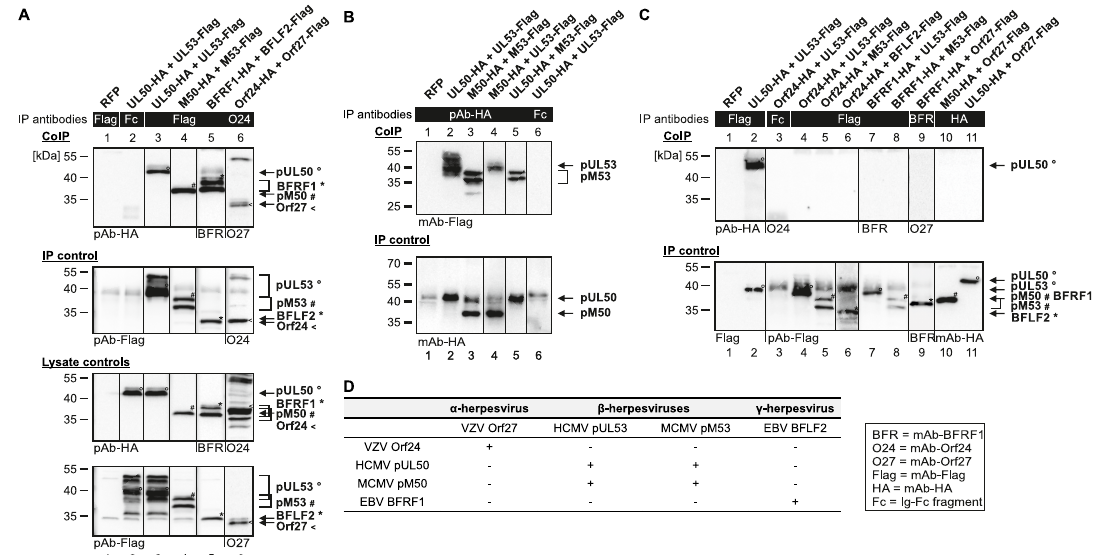
Figure 3. CoIP-based interaction analysis of nonautologous NEC protein pairs derived from HCMV, MCMV, EBV and VZV. 293T cells were transiently transfected with expression plasmids coding for HA-tagged and Flag-tagged versions of NEC proteins as indicated. At three d p.t., cells were lysed and HA- or Flag-tagged proteins were immunoprecipitated using mAb-Flag, mAb-Orf24 (A), pAb-HA (B), mAb-Flag, mAb-BFRF1, mAb-HA (C) or antibody Fc fragment (mouse (A, C) or rabbit (B), as a specificity control). Lysate controls taken prior to the IP and CoIP samples were subjected to standard Wb analysis using tag-specific antibodies as indicated. ( A ) Positive CoIP reactions obtained for autologous pairs of four di ff erent herpesviral core NECs. ( B ) Positive CoIP reactions obtained for nonautologous pairs of herpesviral core NECs, when analyzing protein combinations within β -herpesviral subfamily, HCMV and MCMV. ( C ) Negative CoIP reactions obtained for nonautologous pairs of herpesviral core NECs, when analyzing protein combinations between di ff erent viral subfamilies. The allocation of protein bands is given by symbols on the right referring to those in the image panels of the figure. ( D ) Combined results obtained from